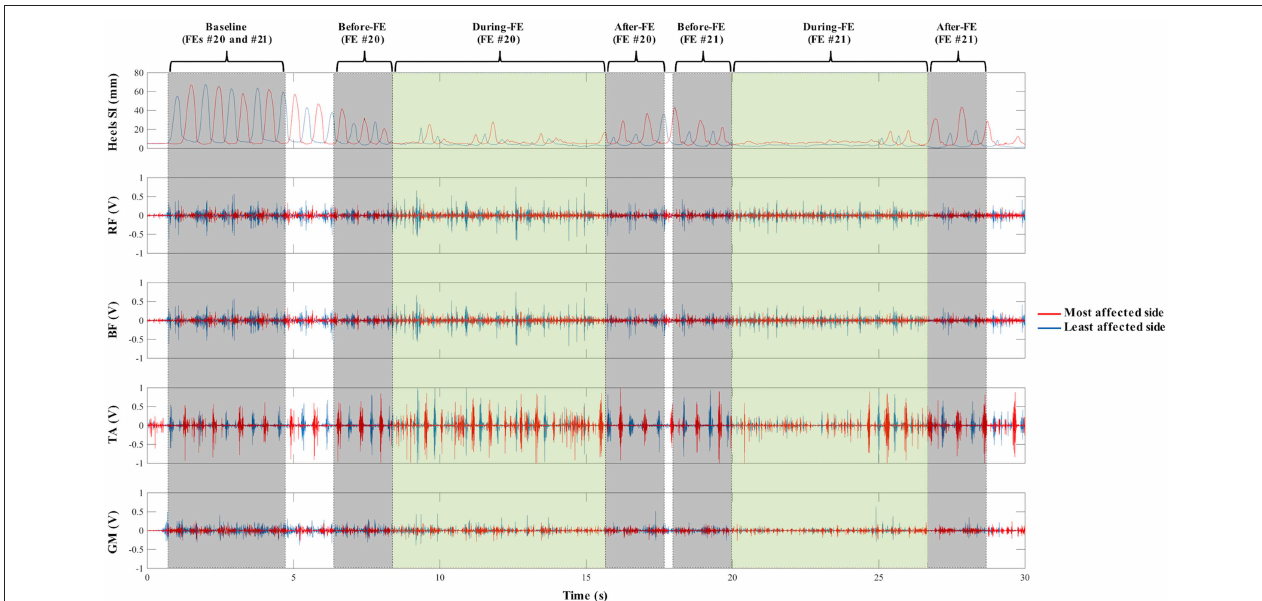
FIGURE 2 | Graphic representation of the four periods extracted from each trial where a freezing episode (FE) was found: 4s of normal performance of the stepping-in-place task at the beginning of the trial (Baseline), 2s before the occurrence of the FE (Before-FE), during the FE (During-FE), and 2s after the end of the FE (After-FE). A representative 30s trial sample (from top to bottom) of bilateral lower limb movement (markers placed on the heels) in the superior-inferior (SI) direction, and of the activity of bilateral rectus femoris (RF), biceps femoris (BF), tibialis anterior (TA), and gastrocnemius medialis (GM) during the stepping-in-place (SIP) task. The red and blue lines represent the most and least affected sides, respectively. A total of two FEs (#20 and #21) were found in this trial. Kinematic data was obtained by using a motion capture system and was not analyzed for this paper. In both TA and least affected GM traces, a slight decrease activation in the times surrounding a FE is seen, especially During-FE compared to Baseline (more in FE #21). Additionally, a less variable EMG trace is seen for all muscles During-FE compared to the other periods, which is recovered by the end of the freezing episodes and After-FE.